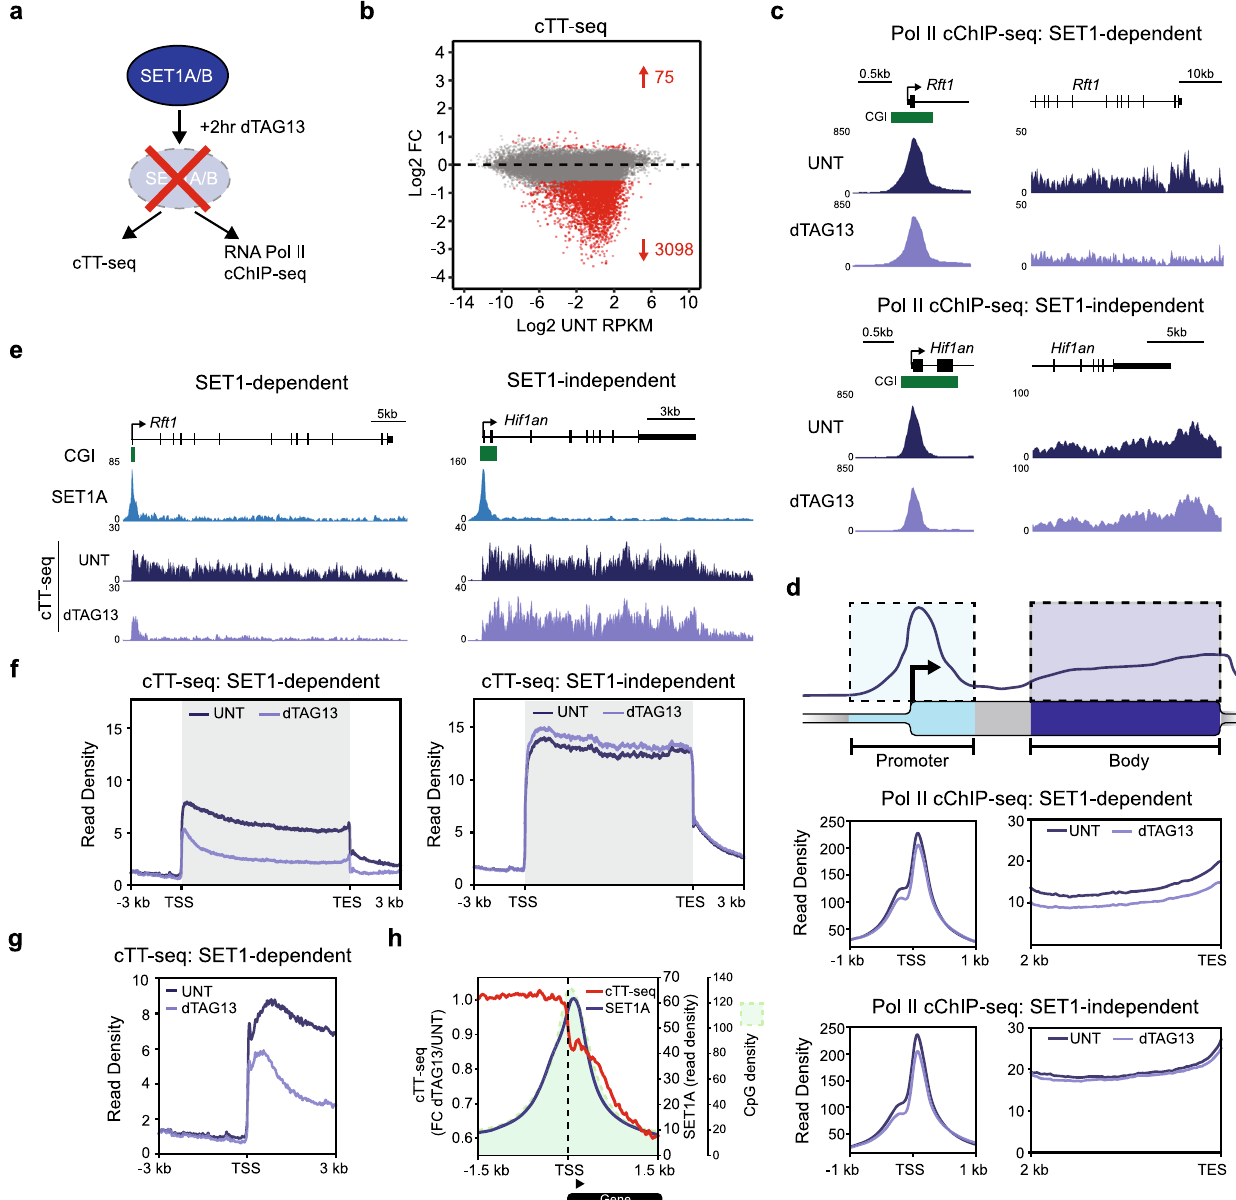
Fig. 4 | SET1 complexes support genic transcription downstream of the TSS. a A schematic illustrating the experiments carried out in the dTAG-SET1A/B line to examine RNA Pol II occupancy (RNA Pol II cChIP-seq) and transcription (cTT-seq). b AnMA-plotshowinglog2foldchanges(Log2FC)intranscription(cTT-seq)inthe dTAG-SET1A/B line following 2h of dTAG13 treatment ( n =20633), determined using DESeq2. Signi fi cant changes in transcription (p-adj < 0.05 and >1.5-fold) are coloured red and the number of signi fi cantly changed genes is indicated. c Genomic snapshots of RNA Pol II occupancy (Pol II cChIP-seq) at a SET1- dependent (upper panel, Rft1 ) and SET1-independent (lower panel, Hif1an ) gene in untreated cells (UNT, dark purple) or cells treated with dTAG13 for 2h (light pur- ple). CGIs are shown in green. The left hand panels correspond to gene promoter occupancyandtherighthandpanelstogenebodyoccupancy. d Thetop panelisa cartoon schematic illustrating the typical RNA Pol II cChIP-seq signal over a gene with the gene promoter region highlighted in light blue and the gene body in light purple.ThebottompanelscorrespondtometaplotanalysisofRNAPolIIcChIP-seq signal in the dTAG-SET1A/B line in cells that are either untreated (UNT) or treated with dTAG13 for 2h. The RNA Pol II cChIP-seq signal corresponding to the gene promoter and body regions (see schematic in top panel) of all transcribed SET1-